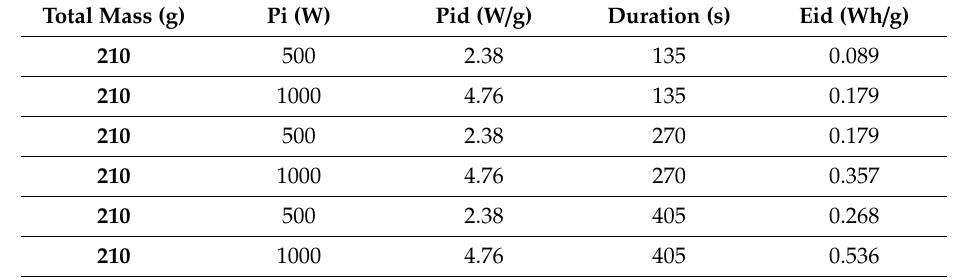
Table 6. Energetic aspects for duration and incident power tested.